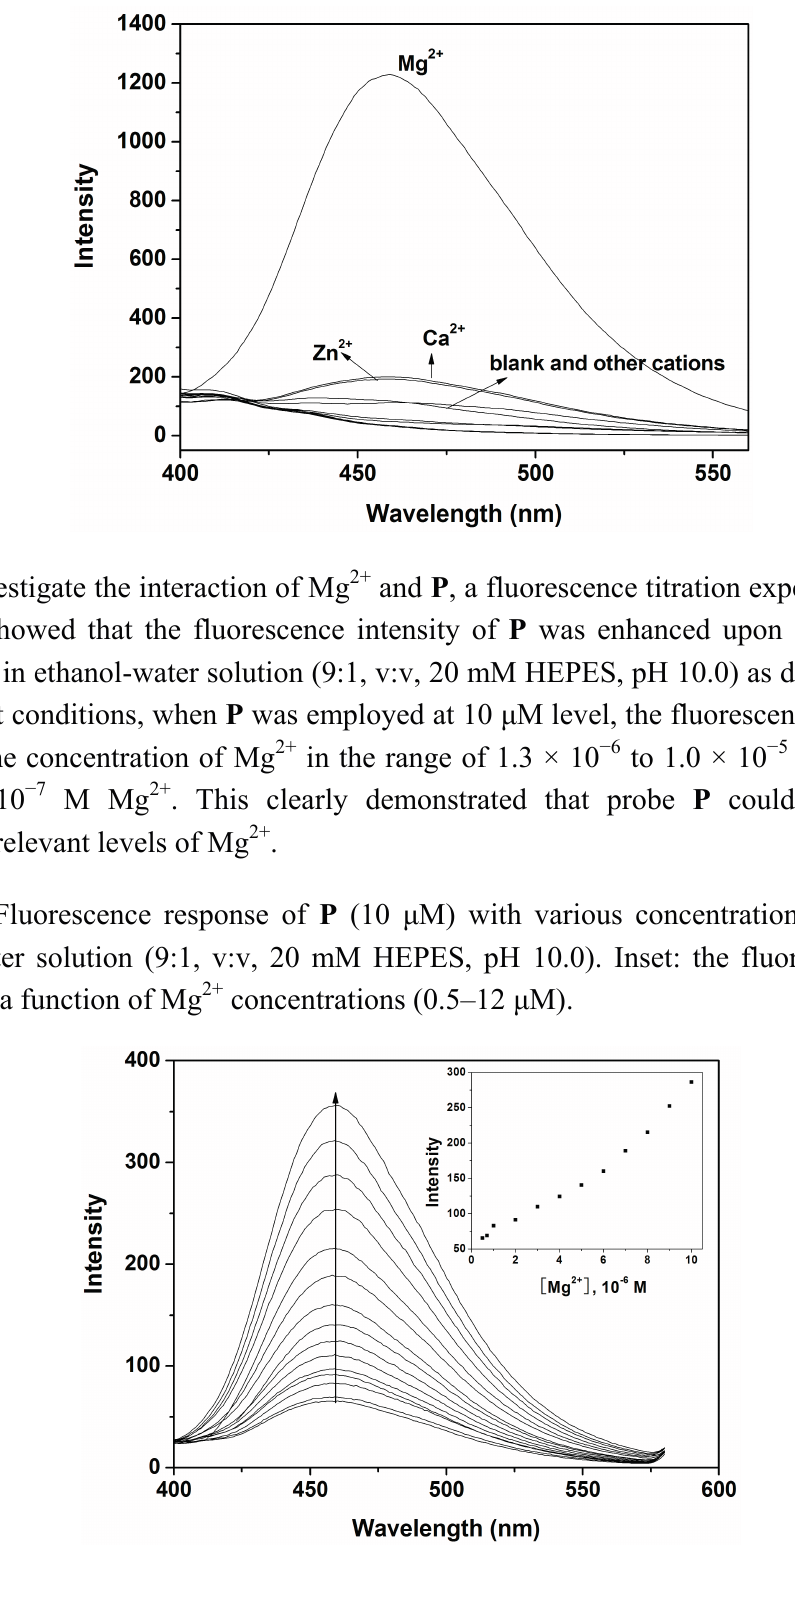
Figure 4. Fluorescence spectra of P (10 μ M) with different metal ions (100 µM) in ethanol-water solution (9:1, v:v, 20 mM HEPES, pH 10.0).